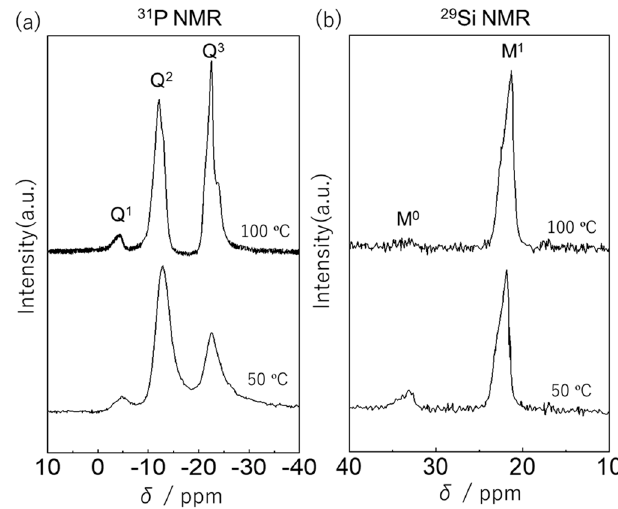
Figure 2. ( a ) The 31 P and ( b ) 29 Si NMR spectra of the products prepared from phosphoric acid and (C 2 H 4 )(Me 2 SiCl) 2 at 50 °C and 100